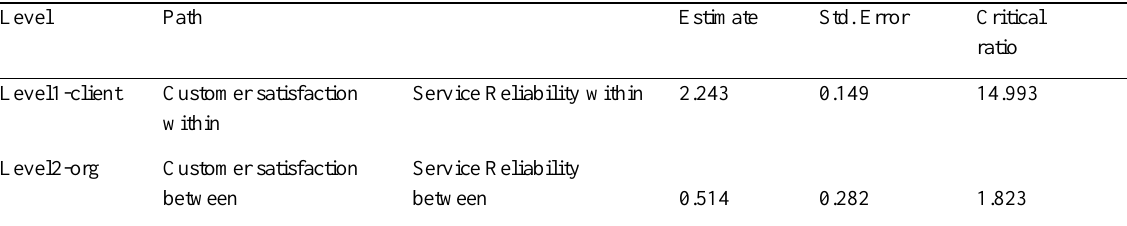
Table 2: Influence of Service Reliability on Customer satisfaction